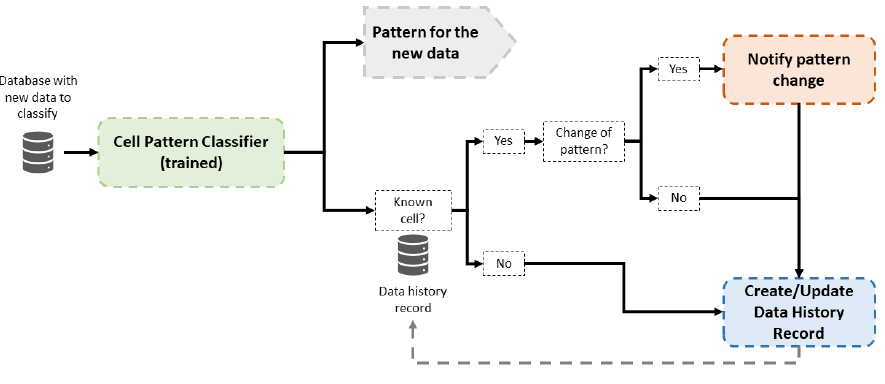
Figure 4. Block diagram of the operation phase in the proposed